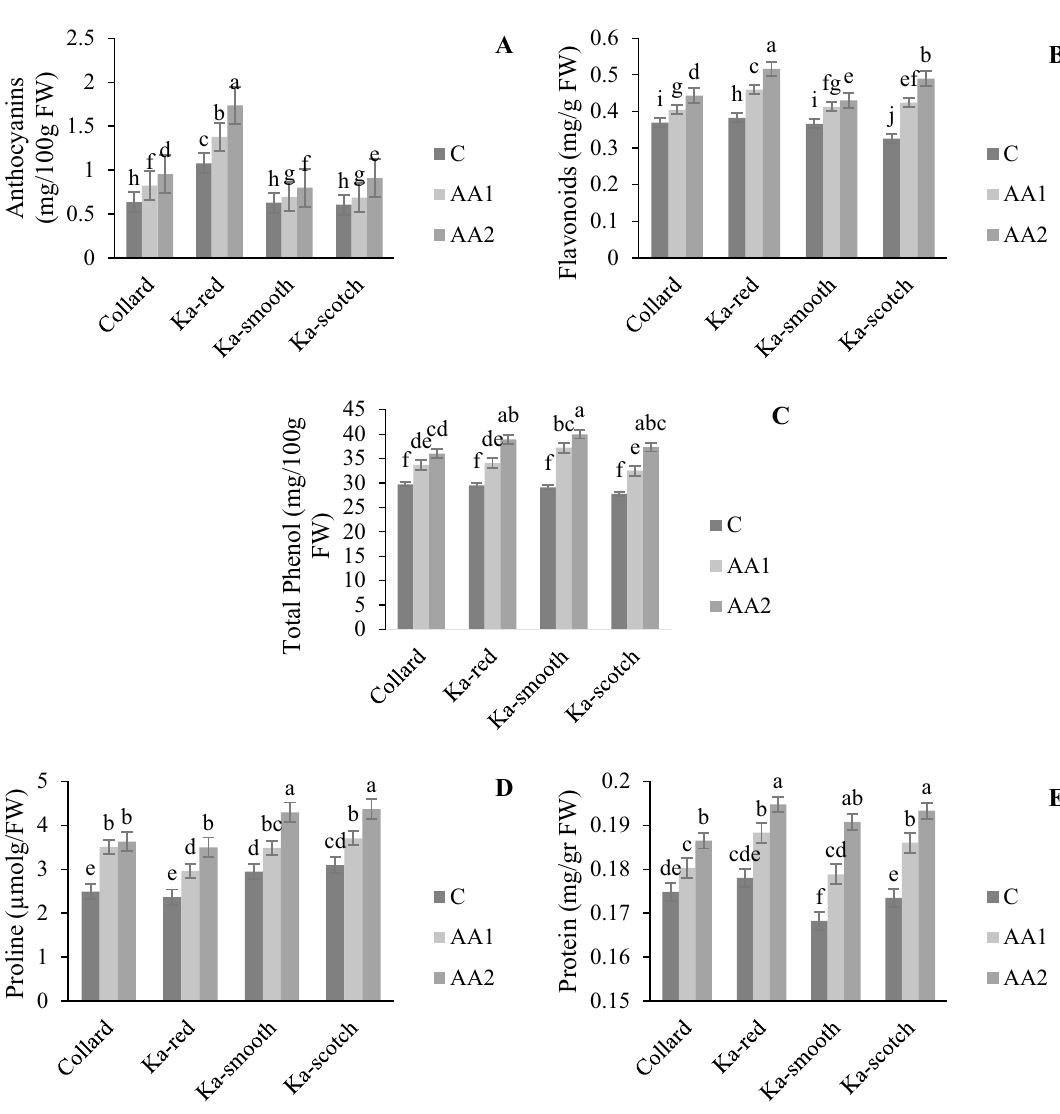
Figure 2. Interaction effect of cabbage cultivar and AA application on anthocyanins ( A ), flavonoids ( B ), phenol ( C ), proline ( D ) and protein ( E ). C control treatment, AA1 150 mg/L of amino acid, AA2 150 and 300 mg/L of amino